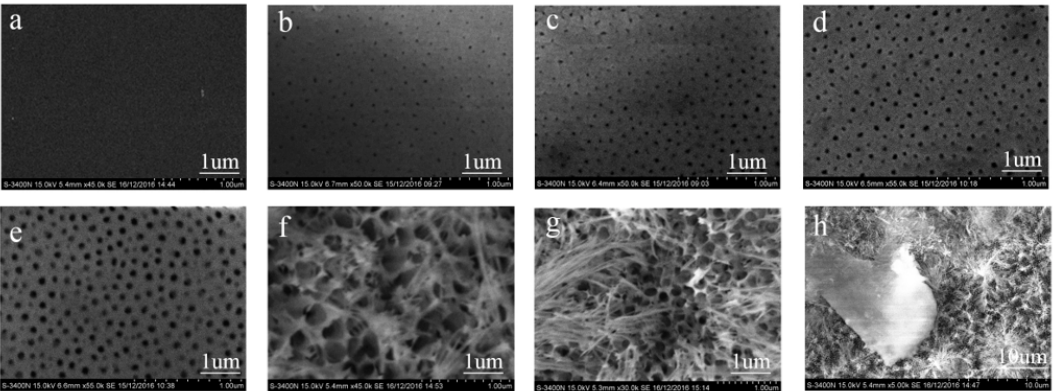
Figure 1. Scanning electron microscope (SEM) images of the prepared plates with different magnitude of current: ( a ) 0 A; ( b ) 1 A; ( c ) 2 A; ( d ) 3 A; ( e ) 4 A; ( f ) 5 A; ( g ) 6 A; ( h ) 7 A.